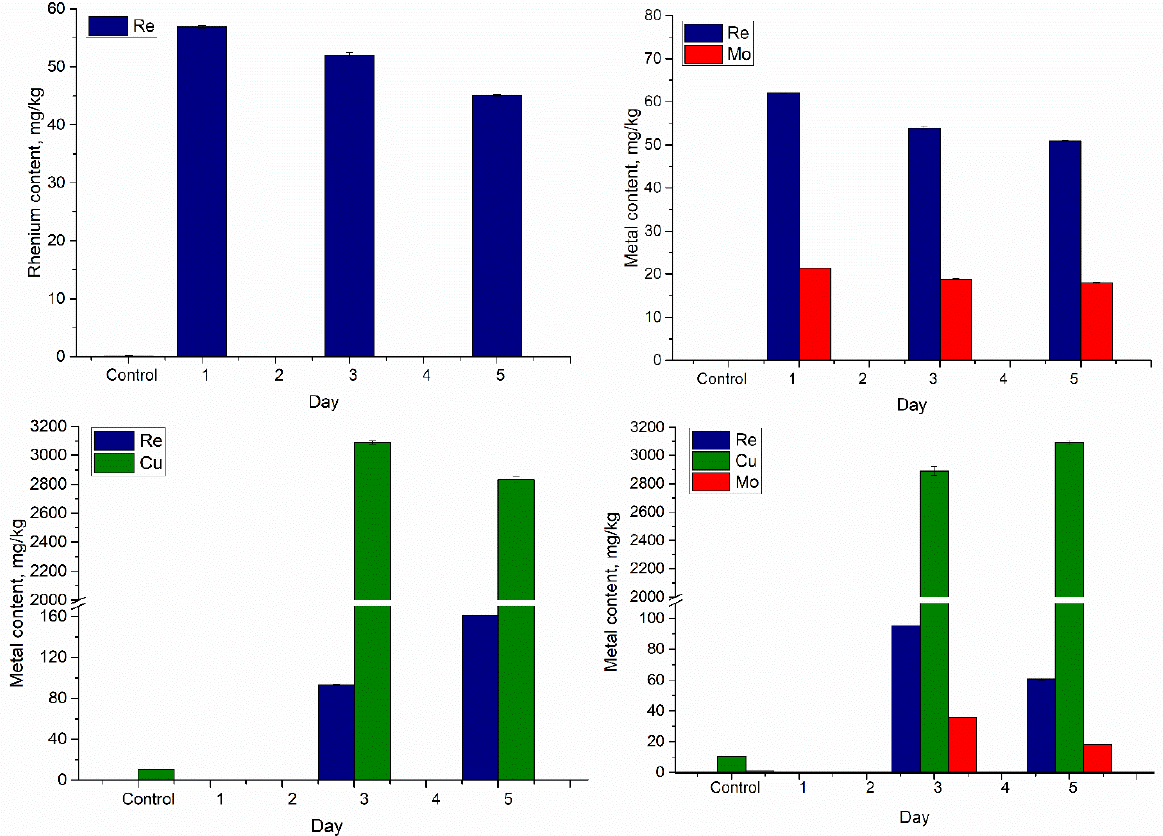
Figure 1. Metal uptake by Spirulina biomass from rhenium-containing effluents with different chemical composition (cultivation days 1, 3, 5, when metal ions were introduced into the cultivation medium; the metal content was determined in the Spirulina biomass grown for six days).